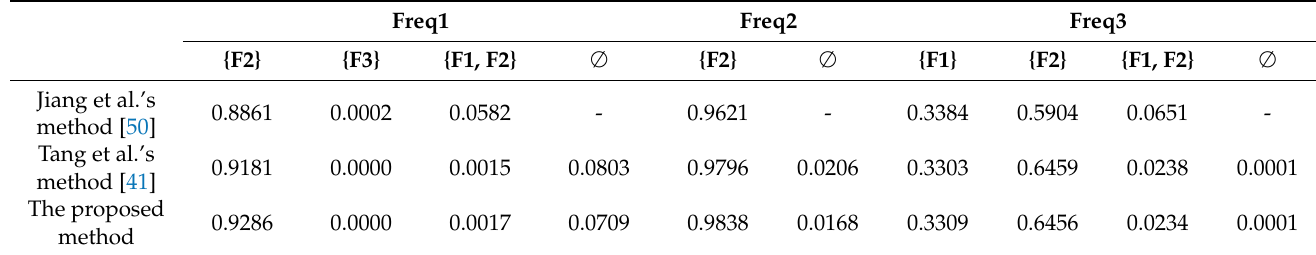
Table 12. Data fusion results of different methods in fault